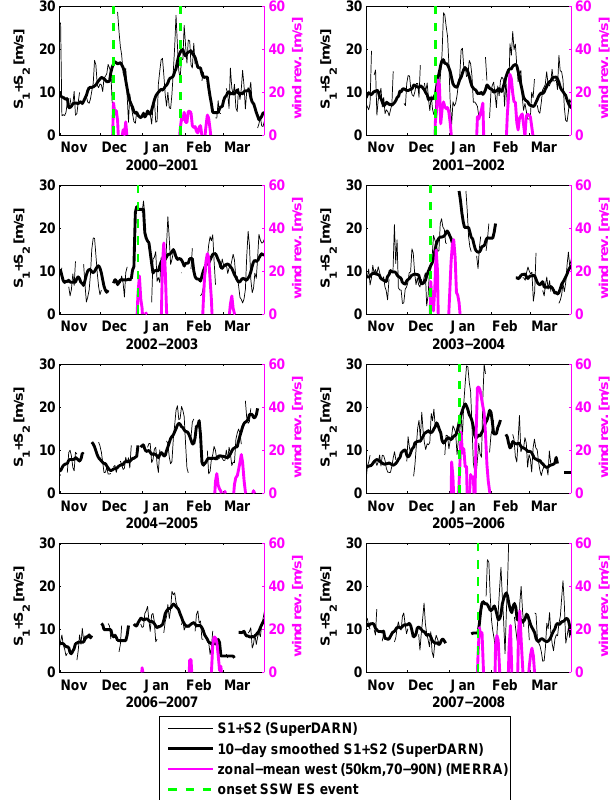
Figure 5. MLT planetary wave amplitudes from SuperDARN (black) and stratospheric westward polar cap (70–90 ◦ N) winds at 0.7hPa ( ∼ 50km) from MERRA (magenta) during winters 2000/2001–2007/2008. The PW amplitudes (black), the sum (thin black line) and the 10-day smoothed sum (thick black line) of the wave number 1 and 2 components ( S 1 + S 2 ) retrieved from the Su- perDARN data. The vertical green line marks the onset of the strato- spheric wind reversal of the composited